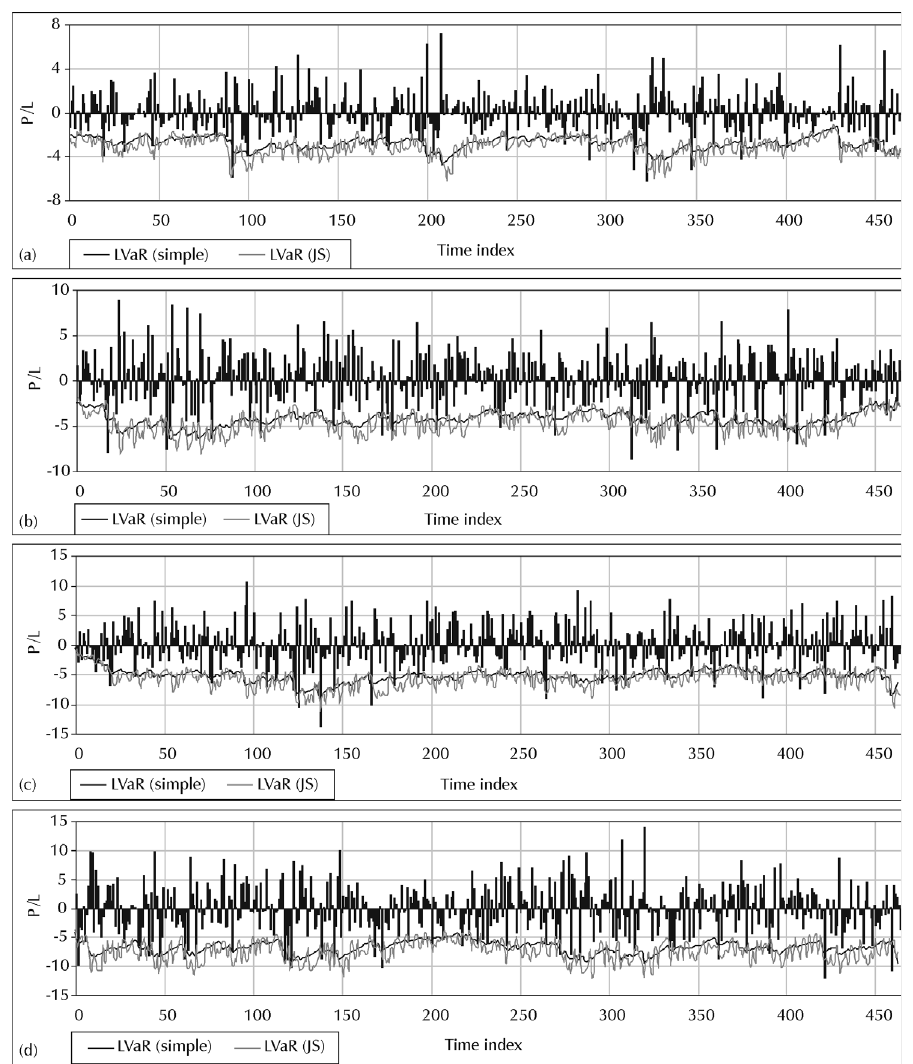
Figure 2. The circled regions show four cases in which the LVaR forecast the VaR incorrectly, simple whilst the LVaR JS